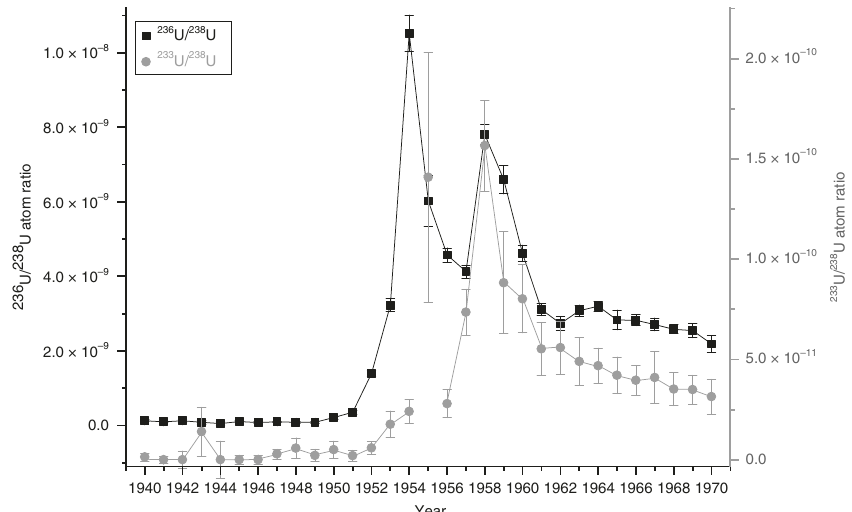
Fig. 2 Measurement results from coral samples. 236 U/ 238 U (black squares) and 233 U/ 238 U atom ratio (gray dots) in the Kume coral core as a function of time. The measurement uncertainties shown are ±1 σ (s.e.m.). The data points are connected by solid lines (bold for 236 U) to guide the eye. The maximum at 1955 is not statistically signi fi cant and thus, not linked to the neighboring